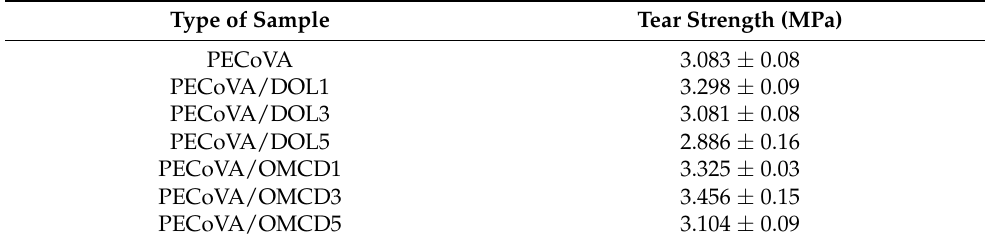
Figure 8. Effect of dolomite filler loading on the Young’s Modulus of virgin PECoVA, PECoVA/DOL and PECoVA/OMCD composites. Table 6. Tear strength of virgin PECoVA, PECoVA/DOL and PECoVA/OMCD